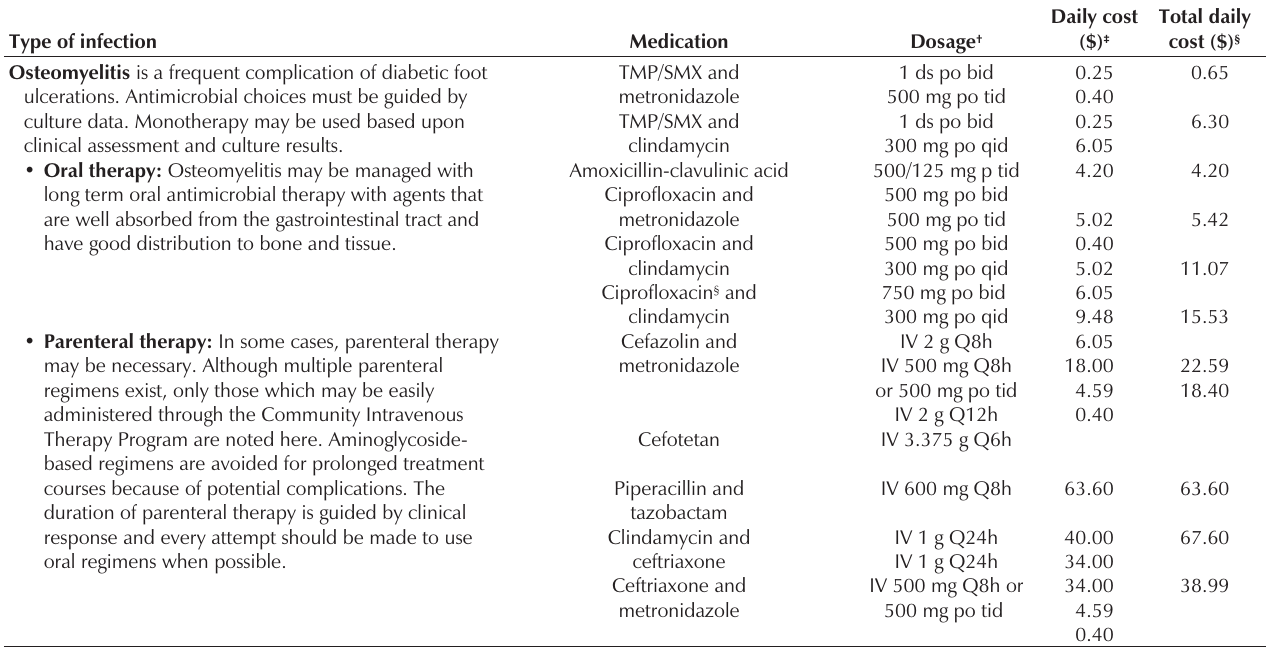
Antibiotic therapy for infected ulcerations in the lower extremity of people with diabetes Type of infection Medication Dosage †